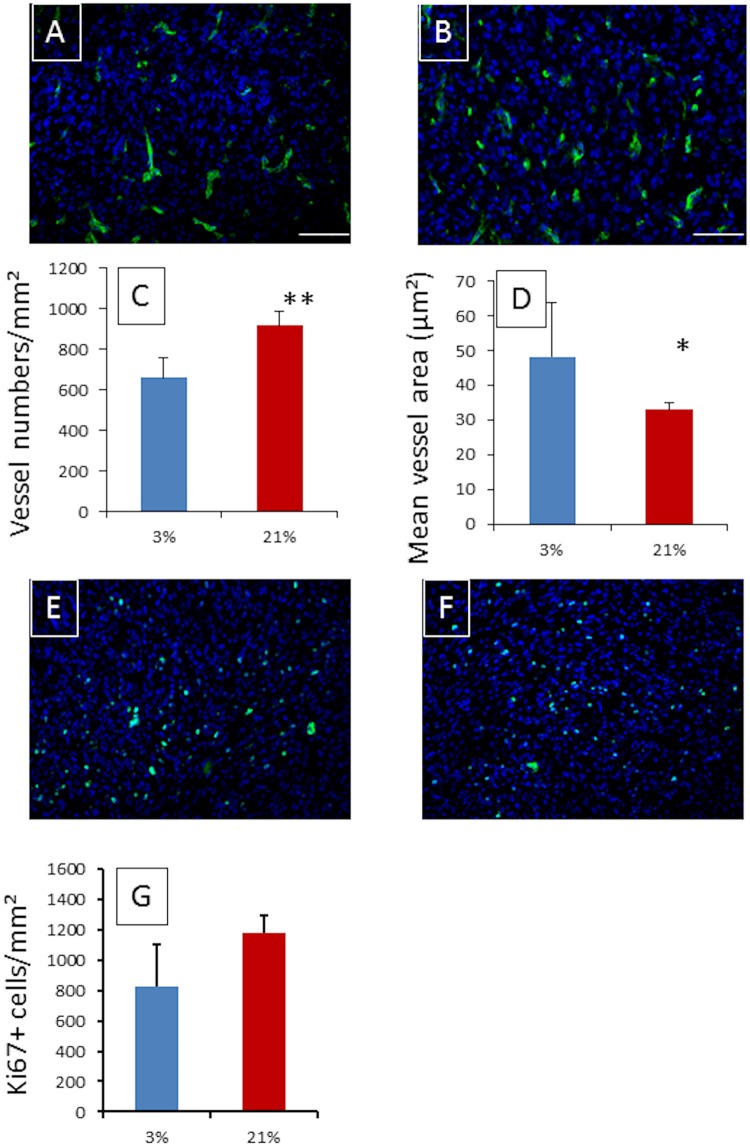
Blood vessel density and cell proliferation assessment with respect to the tumor group explored.Immunofluorescence staining of CD31 and Ki67 in a typical tumor arising from mild hypoxic (3% O2) grown U87-MG cells ((A)—CD31 / (E)–Ki67) and from normoxic grown (21% O2) tumor ((B)—CD31 / (F)–Ki67) once a size of 8μL is reached. Nucleus staining was performed using DAPI (Blue). Scale bar = 100μm. Quantitative vessel density analysis (C) and average vessel area (D) revealed, on average, 668 ± 50 vessels/mm² with an area of 46 ± 5 μm2 in the tumor arising from the cells cultured under mild hypoxia versus 919 ± 35 vessels/mm2 with an area of 33 ± 2 μm2 in the tumor arising from cells cultured under normoxia [p<0.001 for vessel number (**) and p<0.03 for area (*)]. However, the vascular surface average is not significantly different between both groups and is ~3%. The quantitative analysis of Ki67 positive cells is presented in frame (G), and despite non-significant (p = 0.107) on average, 829 ± 138 positive cells/mm2 were counted in the tumor arising from the cells cultures in mild hypoxia condition versus 1178 ± 59 positive cells/mm2 in the tumor arising from cells cultured under normoxia.